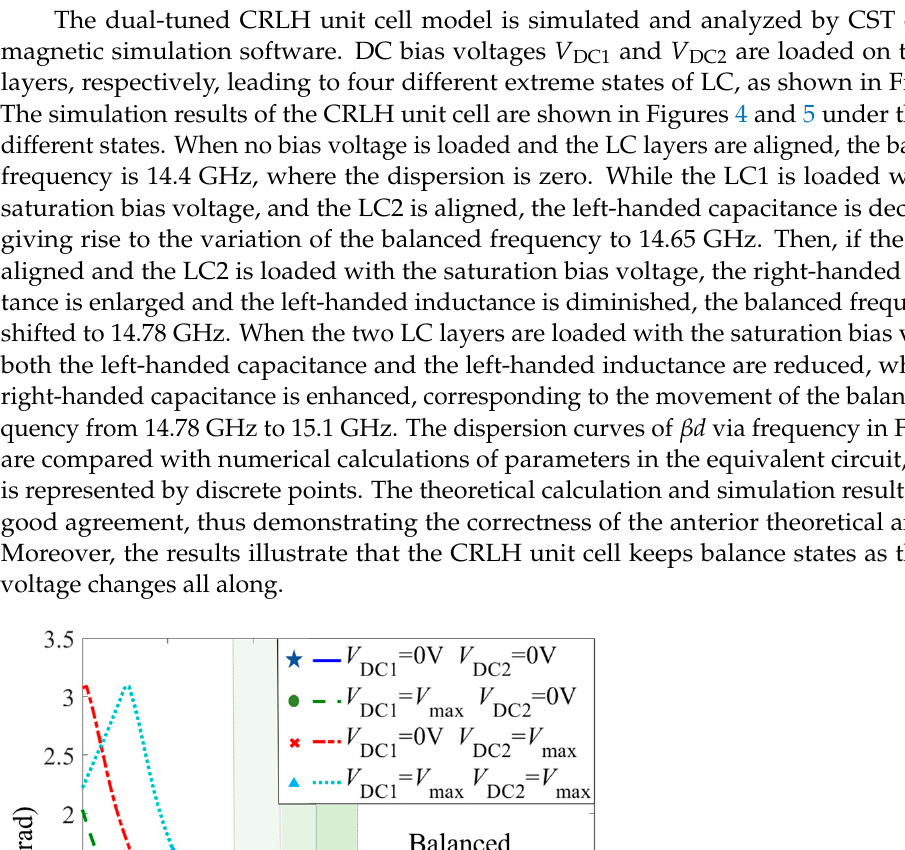
Sensors 2023 , 23 , 2556